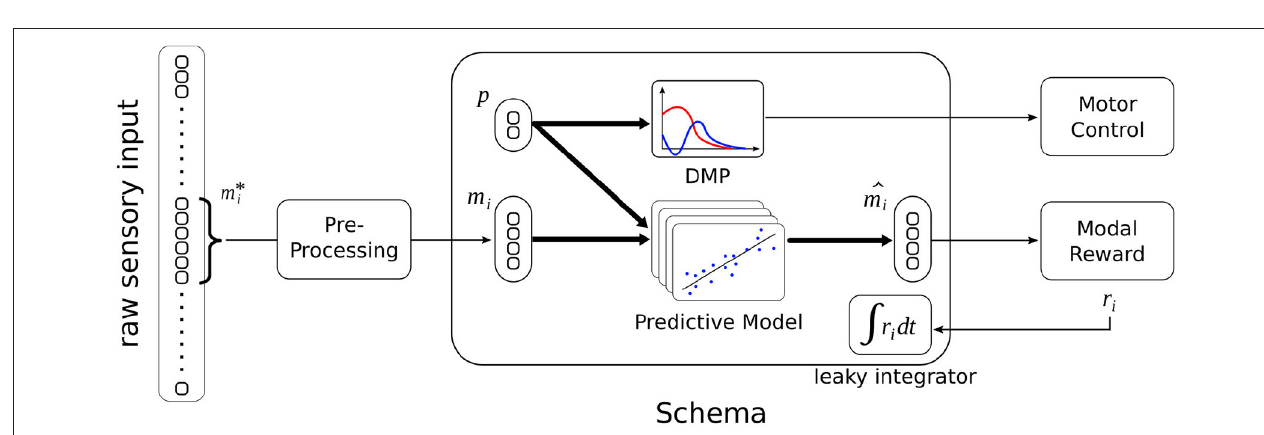
FIGURE 2 | Annotated view of a part of the central region of the simulated environment.